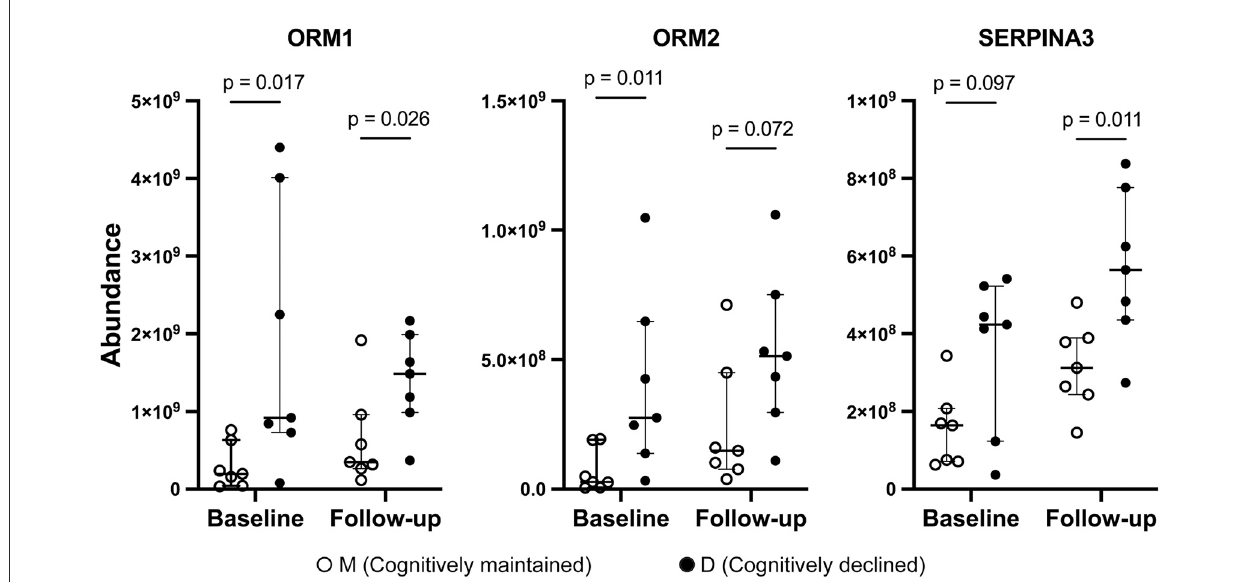
FIGURE2 Abundance of ORM1, ORM2, and SERPINA3 by mass spectrometry. Solid circles: Group D, open circles: Group M. Bars and ranges represent median and interquartile range. P -values were obtained using the Wilcoxon’s rank sum